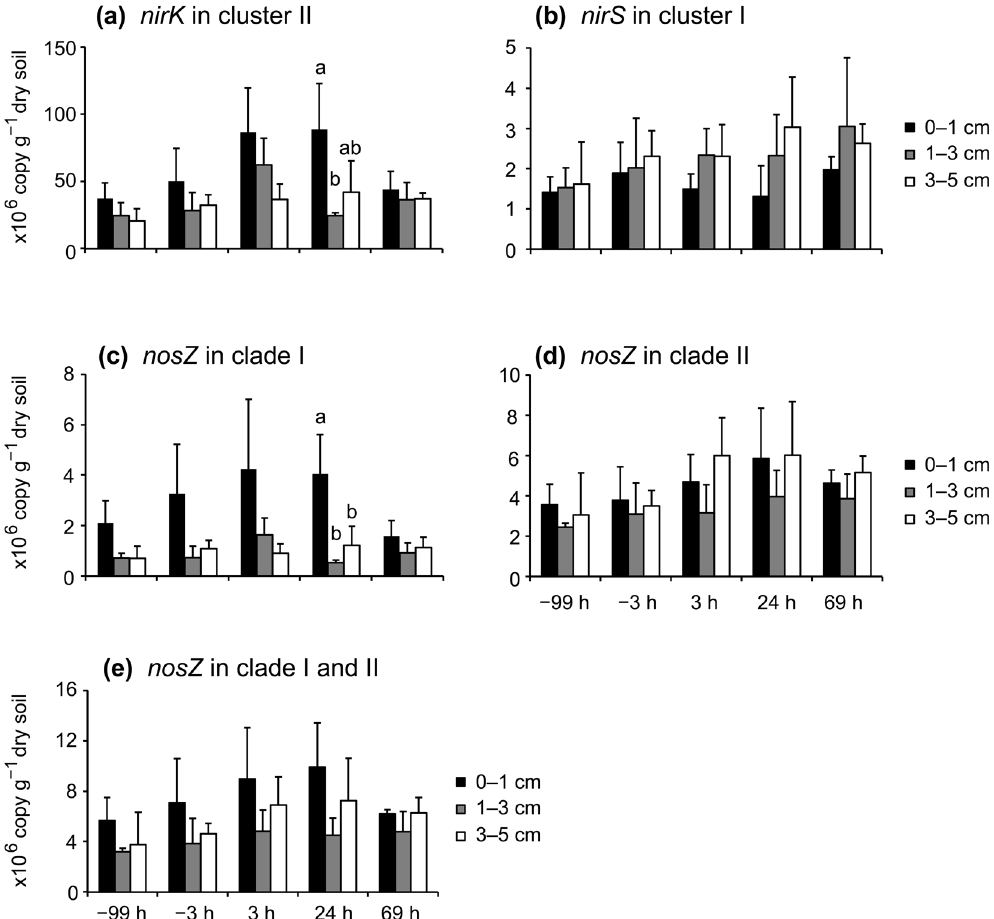
Figure 2. Quantification of the abundance of nirK in cluster II ( a ), nirS in cluster I ( b ), nosZ in clade I ( c ), nosZ in clade II ( d ), and the total quantity of nosZ ( nosZ in clades I and II) ( e ) in soil by qPCR. Error bars represent standard deviations ( n = 3). Different lowercase letters above columns represent significant differences among different soil depths at each sampling